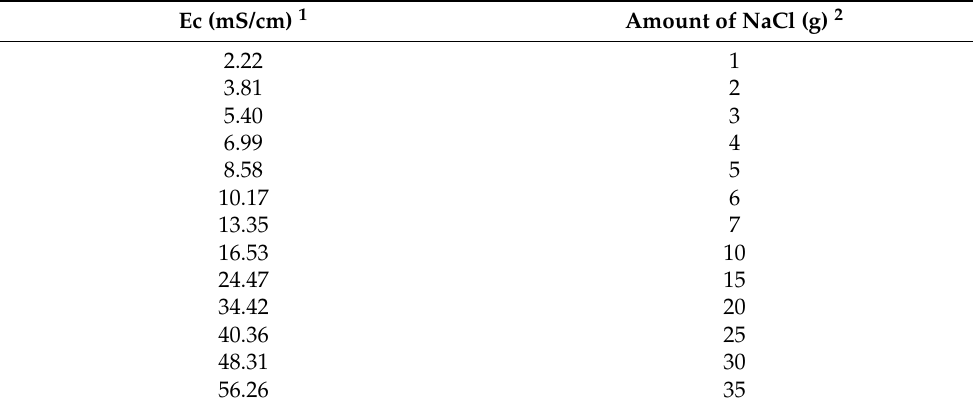
Table 1. Amount of NaCl added to one liter of deionized water and the corresponding electric conductivity (EC).